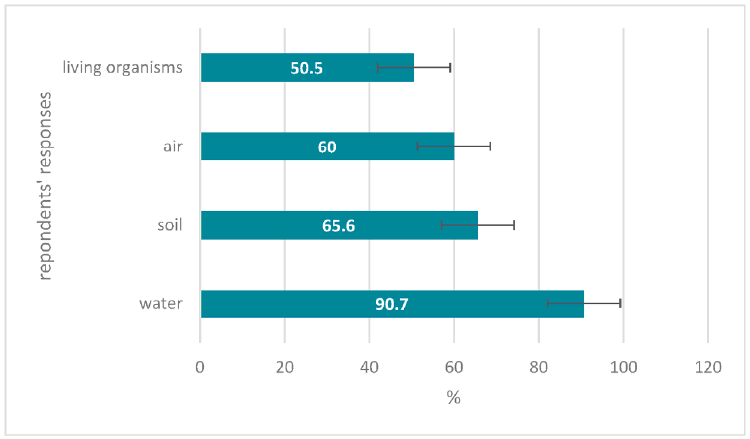
Figure 4. Respondents’ answer to “In what elements of the environment it is possible to find microplastics?” (%).